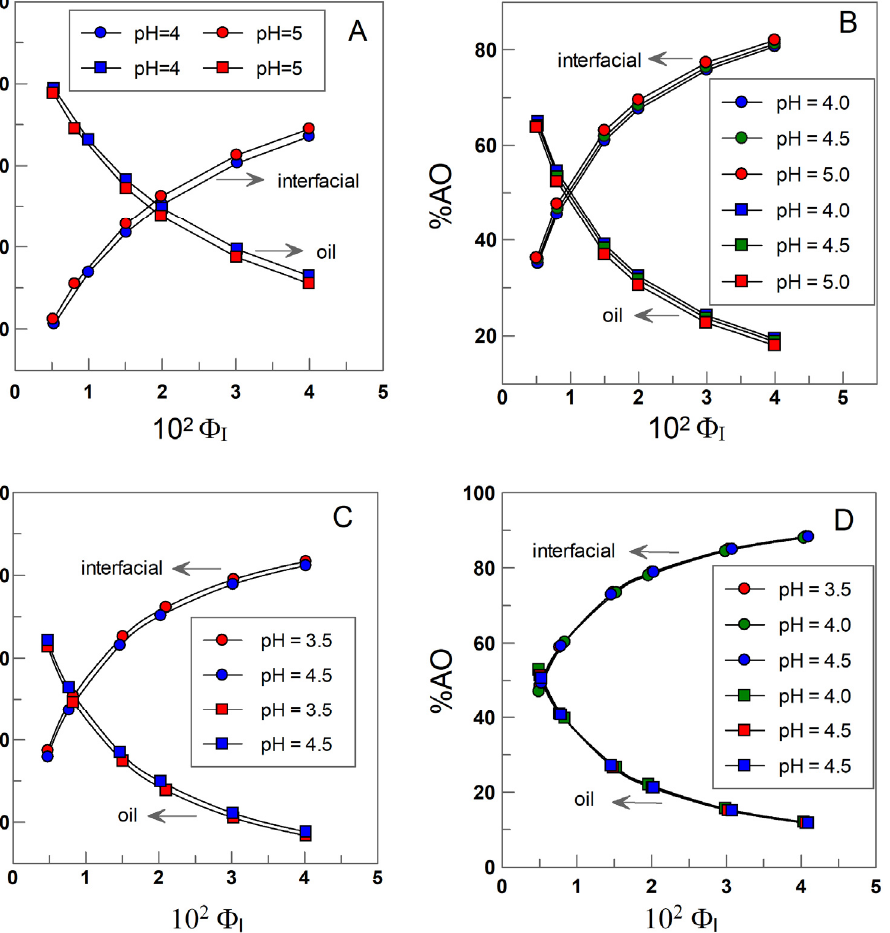
Figure 5. Variation of the percentages of α− TOC ( A , C ) and δ− TOC ( B , D ) with the surfactant volume fraction Φ I in the oil ( ■ ) and interfacial ( ● ) regions of 1:9 olive ( A , B ) and soybean ( C , D ) oil emulsions at different acidities.